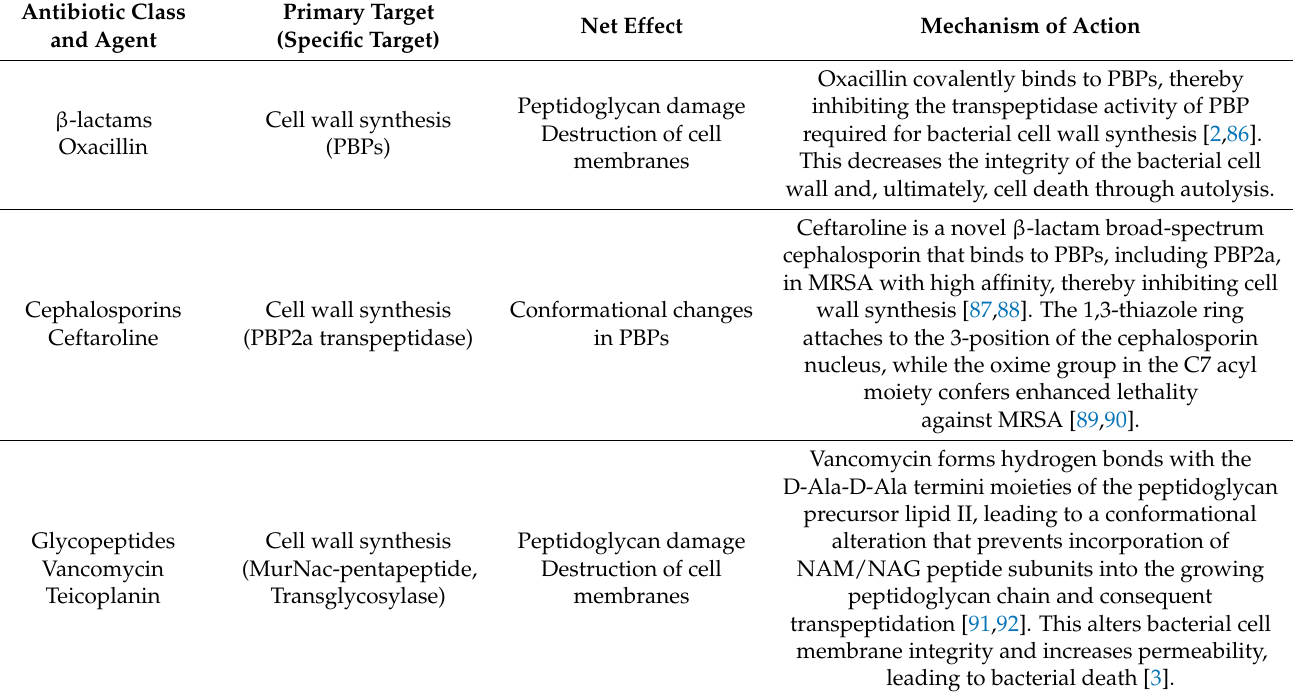
Table 2. Targets of antibiotics in S. aureus and their mechanisms of